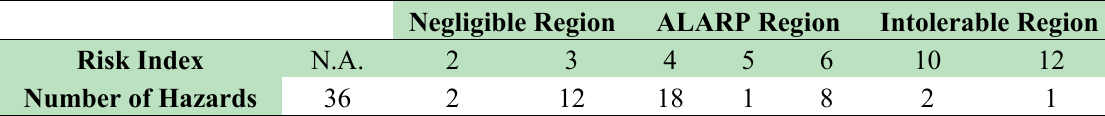
Table 8. Number of hazards by risk index.